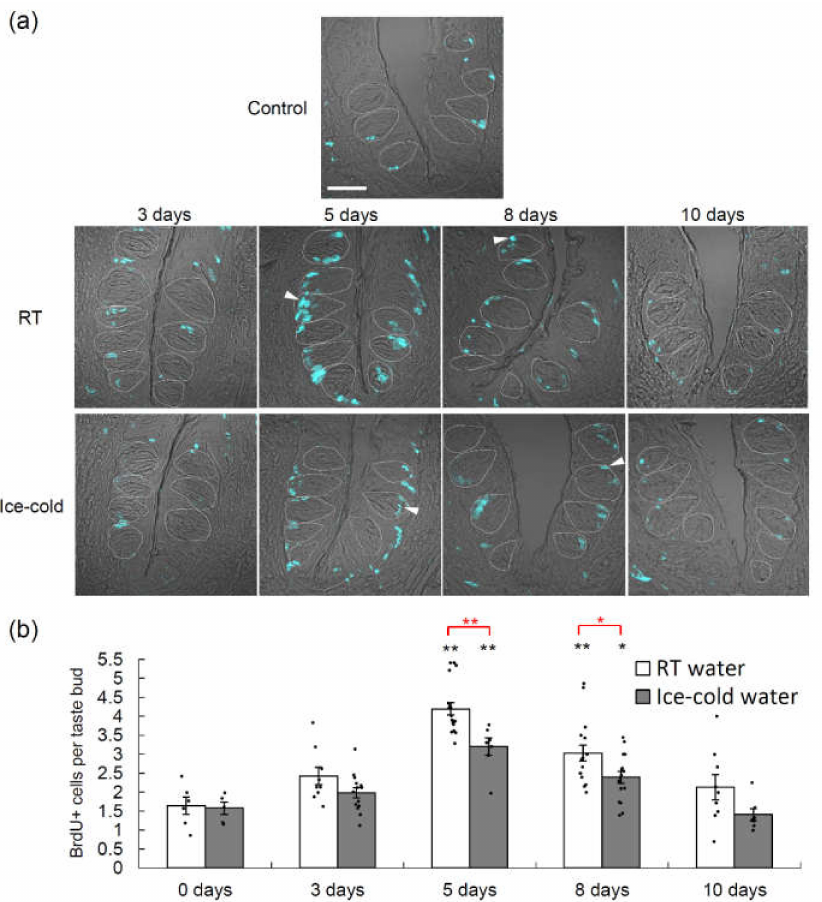
Figure 3. Bromodeoxyuridine (BrdU) labeling of the circumvallate papillae of mice that drank room temperature (RT) water or ice-cold water during the 10-day period following the administration of TPF (docetaxel, cisplatin and 5-fluorouracil). ( a ) BrdU signals (cyan) in the circumvallate papillae before (0 days) and 3, 5, 8 and 10 days after TPF administration for mice that drank RT water or ice-cold water. Arrowheads indicate BrdU-positive proliferative cells. Dotted lines outline individual taste buds. Scale bar: 50 µ m. ( b ) Quantitation of the number of BrdU-positive cells per taste bud at di ff erent time points after TPF administration for mice that drank RT water and those that drank ice-cold water. Data are expressed as the mean ± SEM ( n = 5–18 trenches, each). Dots indicate individual data points. * (in black) p < 0.05 vs. control (0 days), ** (in black) p < 0.01 vs. control (0 days) (one-way ANOVA and Tukey’s post-hoc test); * (in red) p < 0.05, ** (in red) p < 0.01 for comparison between RT water and ice-cold water (two-way ANOVA and post-hoc t